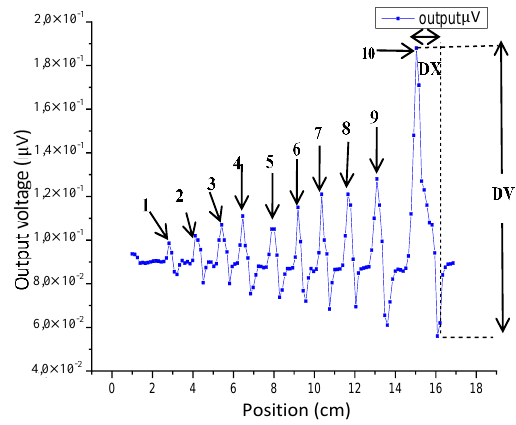
FIGURE 14 Results Typical giant magnetoresistance voltage of cracks for the 10 nominal depths which are d=1, 2,3,4,5,6,7,8,9,10 mm for each nominal width: w1=0.67 mm, w2=0.68 mm, w3=0.68 mm, w4=0.69 mm, w5=0.65 mm, w6=0.62 mm, w7=0.57 mm, w8=0.47 mm, w9=0.61 mm, w10=0.55 mm.